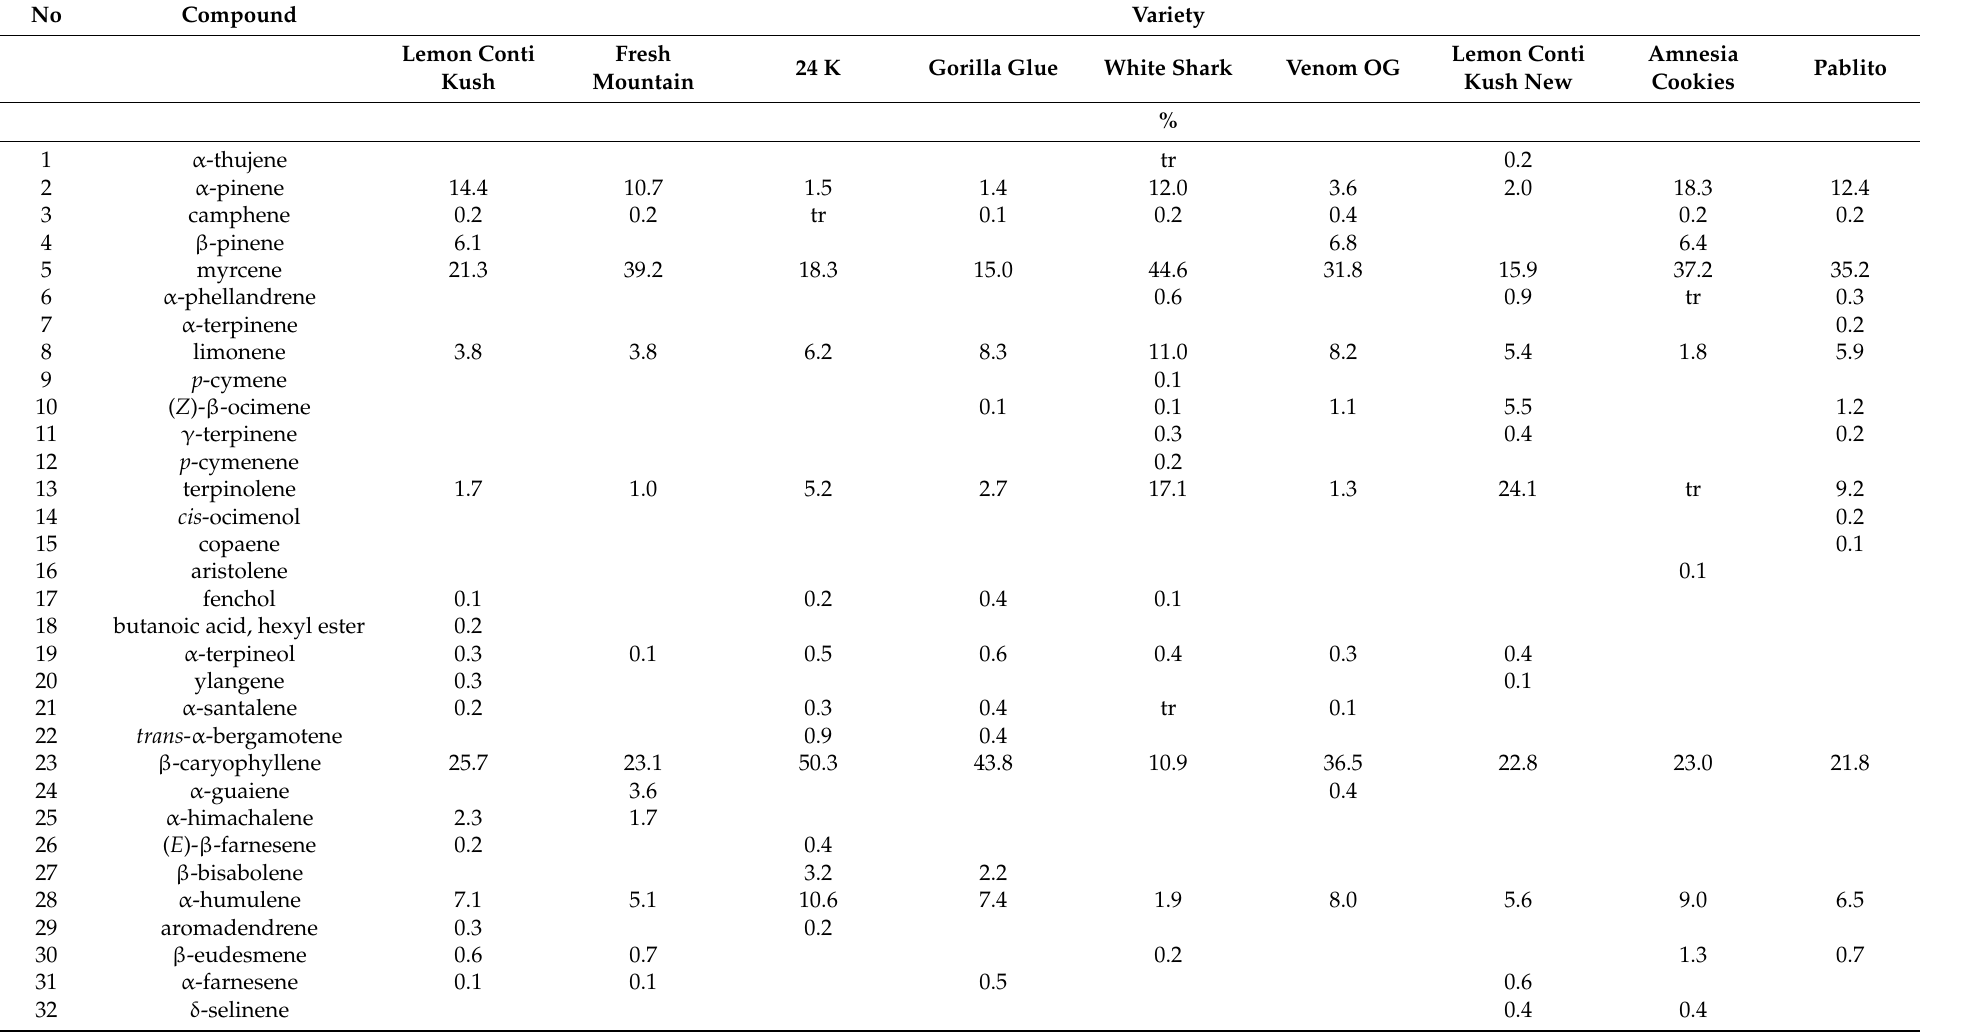
Table 4. SPME-GC-MS analysis results for the 9 commercial varieties’